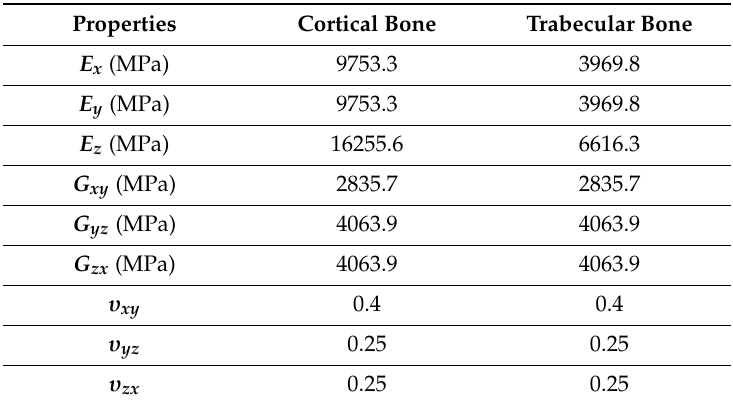
Table 1. Material properties of cortical and trabecular bone (Young’s modulus, shear modulus and Poisson’s